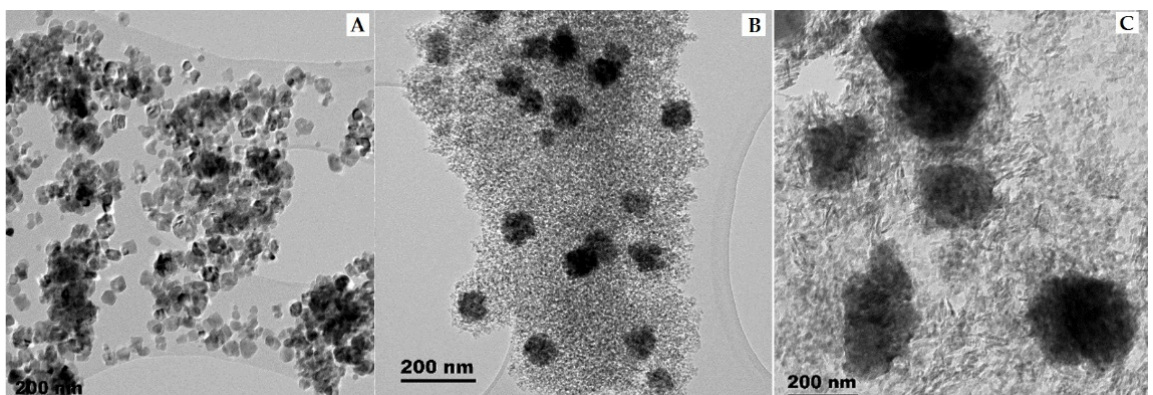
Figure 1. TEM micrograph images of a freshly calcined catalyst: ( A ) Co/TiO 2 , ( B ) Co/SiO 2 , and ( C ) Co/Al 2 O 3 .